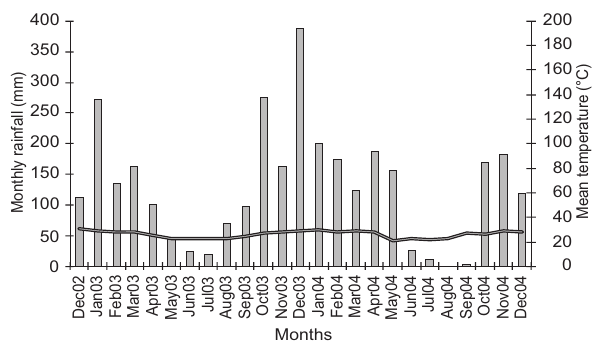
Figure 1. Monthly rainfall (bars) and monthly mean temperature (line) in Rio Negro farm from December 2002 to December 2004 (data provided by Donald P. Eaton, Earthwatch